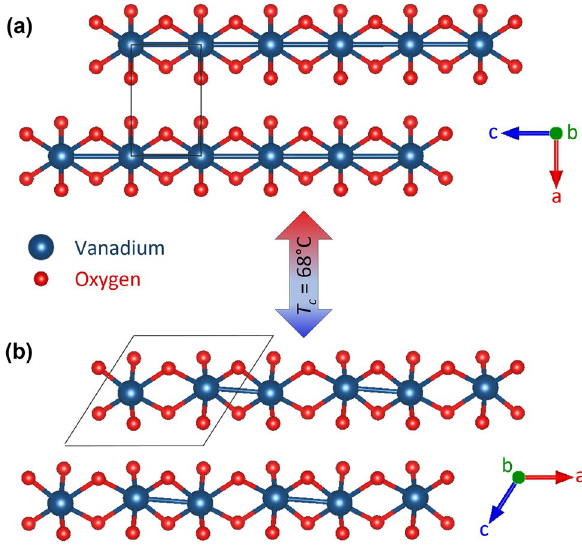
Figure 1. Structural changes across the MIT illustrating V–V dimerization changes accompanying structure transformation from ( a ) P 4 2 / mnm to ( b ) P 2 1 / c upon cooling with T c occuring at 68